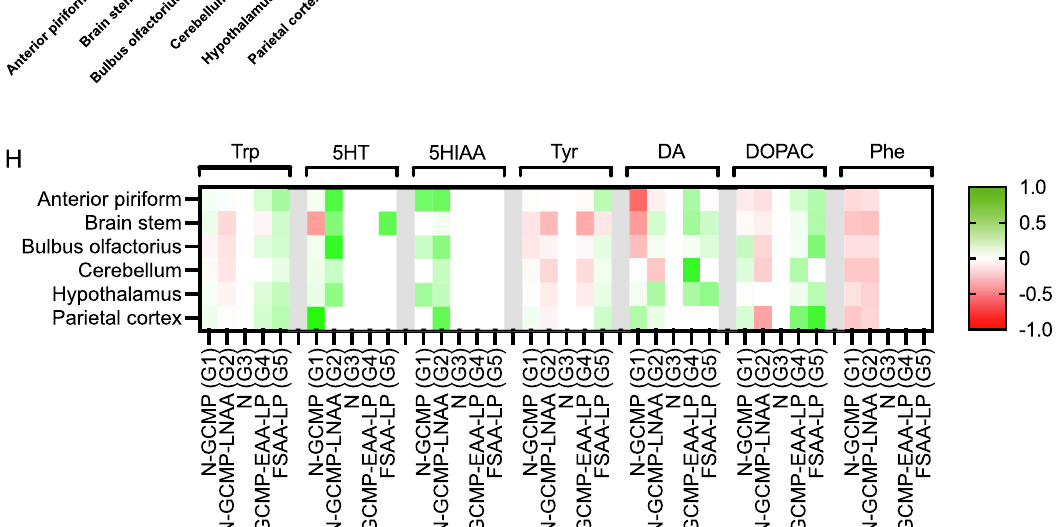
PLOS ONE | https://doi.org/10.1371/journal.pone.0261150 January 11,